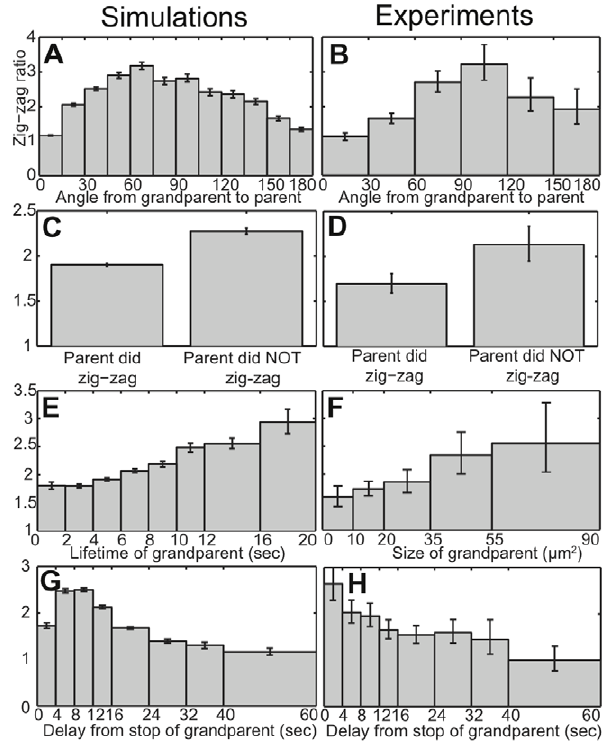
Figure 5. Model predictions for pseudopod zig-zag ratios (A,C,E,G) compared with experimental data (B, D, F, H). A,B) Pseudopod zig-zag ratios versus the angle from grandparent to parent. C,D) Dependence of pseudopod zig-zag ratio on whether or not the pseudopod’s parent zig-zagged. E,F) Pseudopod zig-zag ratio versus the size of the grandparent pseudopod. For simulated data (E) lifetime is used as a proxy for size. G,H) Pseudopod zig-zag ratio versus the time interval from the stop of the grandparent to the start of the